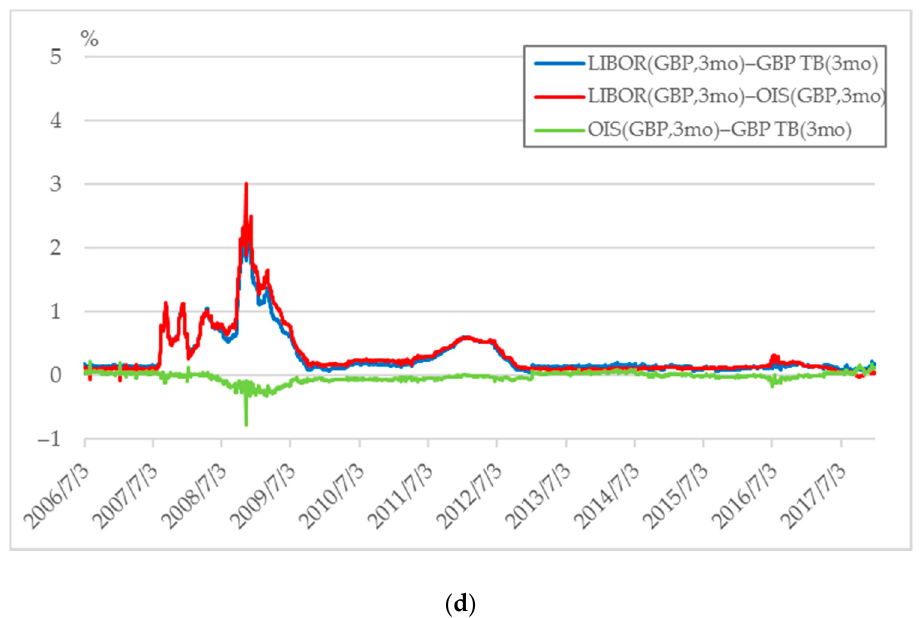
Figure 6. ( a ) Credit Risk Premium and Liquidity Risk Premium for the USD. Data: Datastream, Credit risk = London Interbank Offered Rate (LIBOR) (USD, 3 months) minus Overnight Indexed Swap (OIS) rate (USD, 3 months), liquidity risk = OIS minus US Treasury Bills (TB) rate (USD, 3 months). ( b ) Credit Risk Premium and Liquidity Risk Premium for the EUR. Data: Datastream, Credit risk = London Interbank Offered Rate (LIBOR) (EUR, 3 months) minus Overnight Indexed Swap (OIS) rate (EUR, 3 months), liquidity risk = OIS minus yields on German treasury discount paper (Bubills) (EUR TB rate) (euro, 3 months). ( c ) Credit Risk Premium and Liquidity Risk Premium for the JPY. Data: atastream, Credit risk = London Interbank Offered Rate (LIBOR) (JPY, 3 months) minus Overnight Indexed Swap (OIS) rate (JPY, 3 months), liquidity risk = OIS minus yields on Japanese Treasury Discount Bills (JPY TB rate) (JPY, 3 months). ( d ) Credit Risk Premium and Liquidity Risk Premium for the GBP. Data: Datastream, Credit risk = London Interbank Offered Rate (LIBOR) (GBP, 3 months) minus Overnight Indexed Swap (OIS) rate (GBP, 3 months), liquidity risk = OIS minus Yields on UK Government bonds (gilts) (GBP TB rate) (GBP, 3 months).